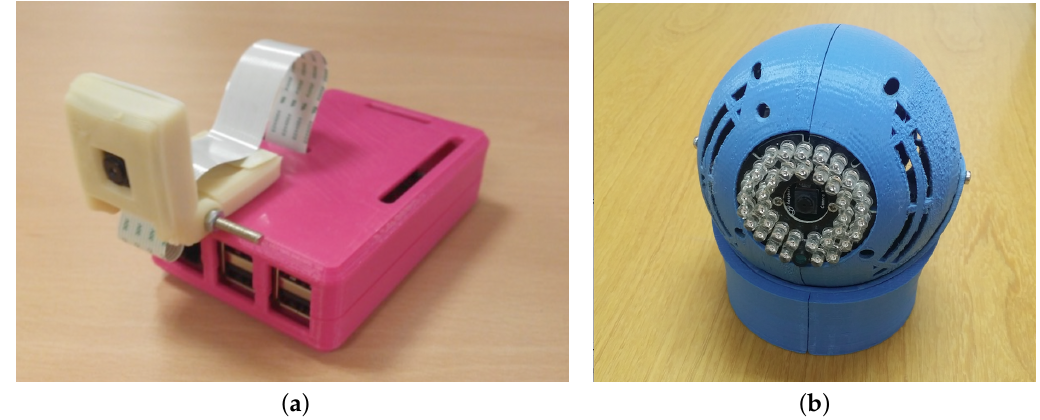
Figure 1. Fall detection system prototypes. ( a ) first prototype; ( b ) second prototype.